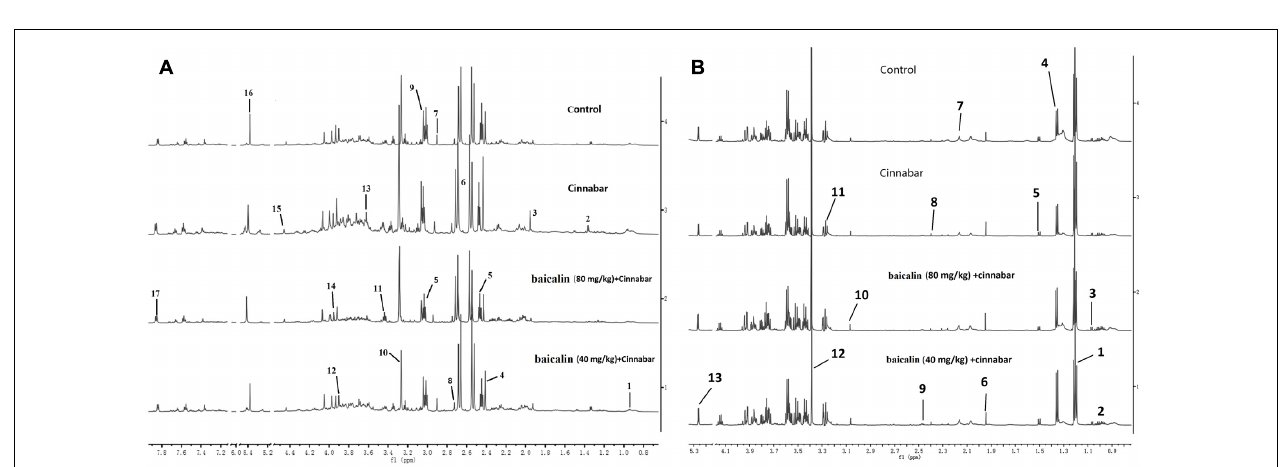
FIGURE 3 | (A) 600 MHz spectra of urine obtained from rats from the Control, cinnabar, HBC group and LBC group. Key: 1, leucine+isoleucine; 2, lactate; 3, acetate; 4, pyruvate; 5, 2-ketoglutarate; 6, citrate; 7, dimethylglycine; 8, dimethylamine; 9, creatine; 10, trimethylamine-N-oxide; 11, taurine; 12, betaine; 13, glycine; 14, creatinine; 15, malate; 16, allantoin; 17, hippurate. 2 (B) 6 00MHz spectra of serum obtained from rats from the Control, cinnabar, HBC group and LBC group. Key: 1, VLDL/LDL-CH 2 -; 2, leucine+isoleucine; 3, valline; 4, lactate; 5, alanine; 6, acetate citrate; 7, pyruvate; 8, 2-ketoglutarate; 9, citrate; 10, creatine; 11, choline; 12, trimethylamine-N-oxide; 13, unsaturated